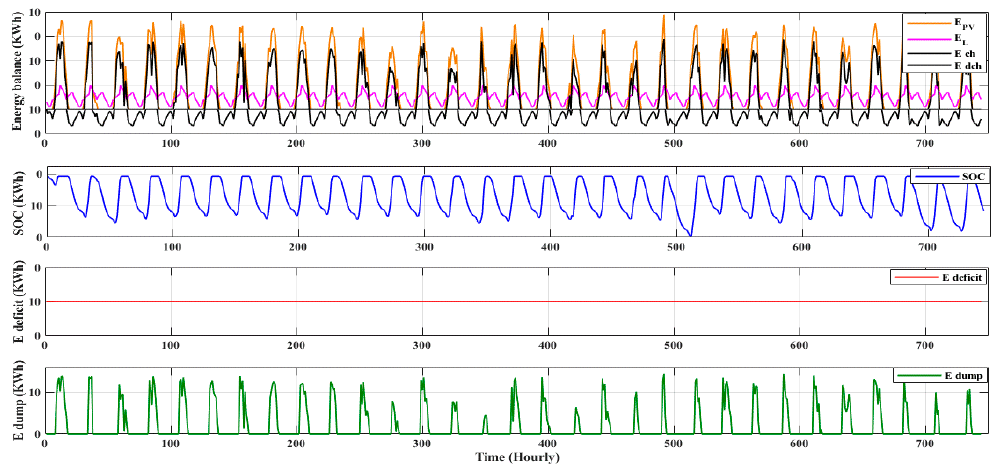
Figure 14. Performance of the SAPV system based on chosen optimal configuration in March.